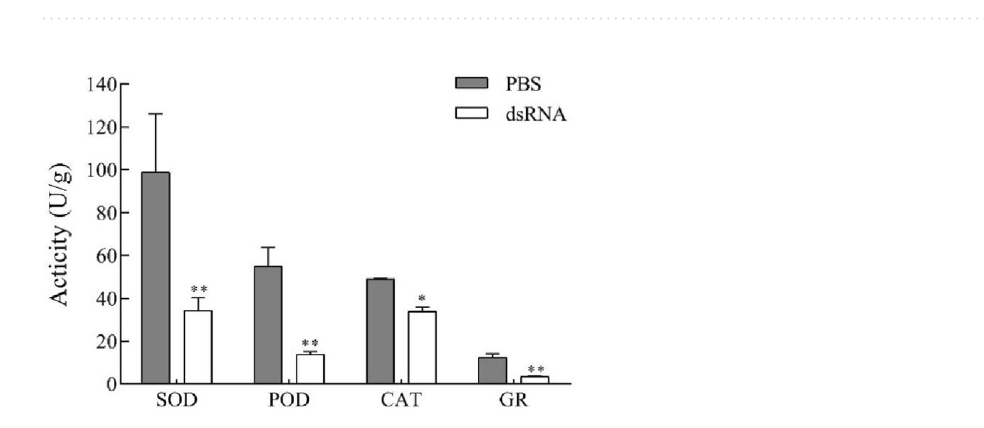
Figure 5. Detection of silencing efficiency. The relative expression levels of Hap38 MAPK were detected in adults. The bars represent means ± SE and asterisks on bars indicate significant differences. The sample size was 50 adults (* P < 0.05, ANOVA).